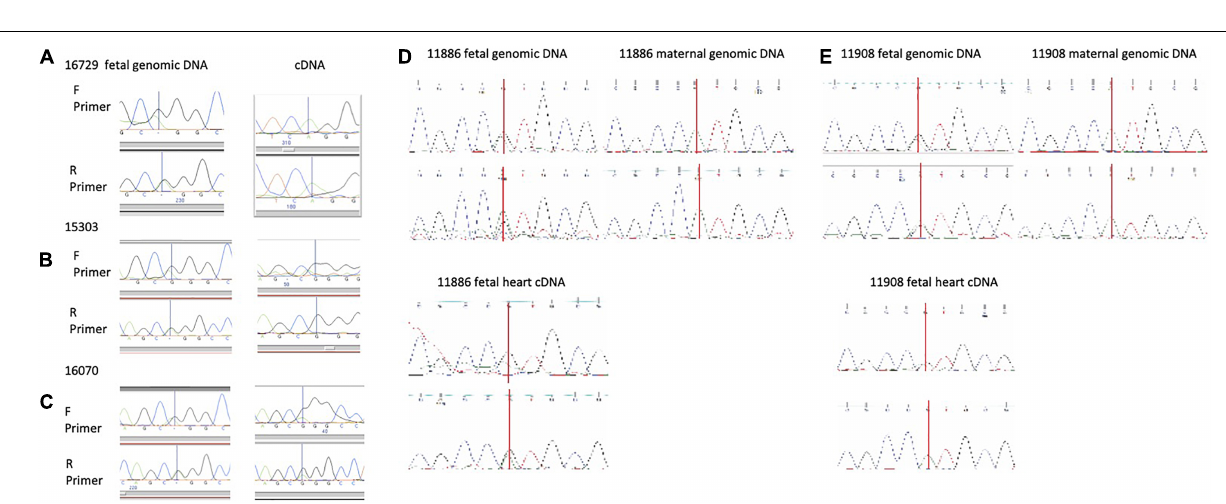
Frontiers in Cell and Developmental Biology |